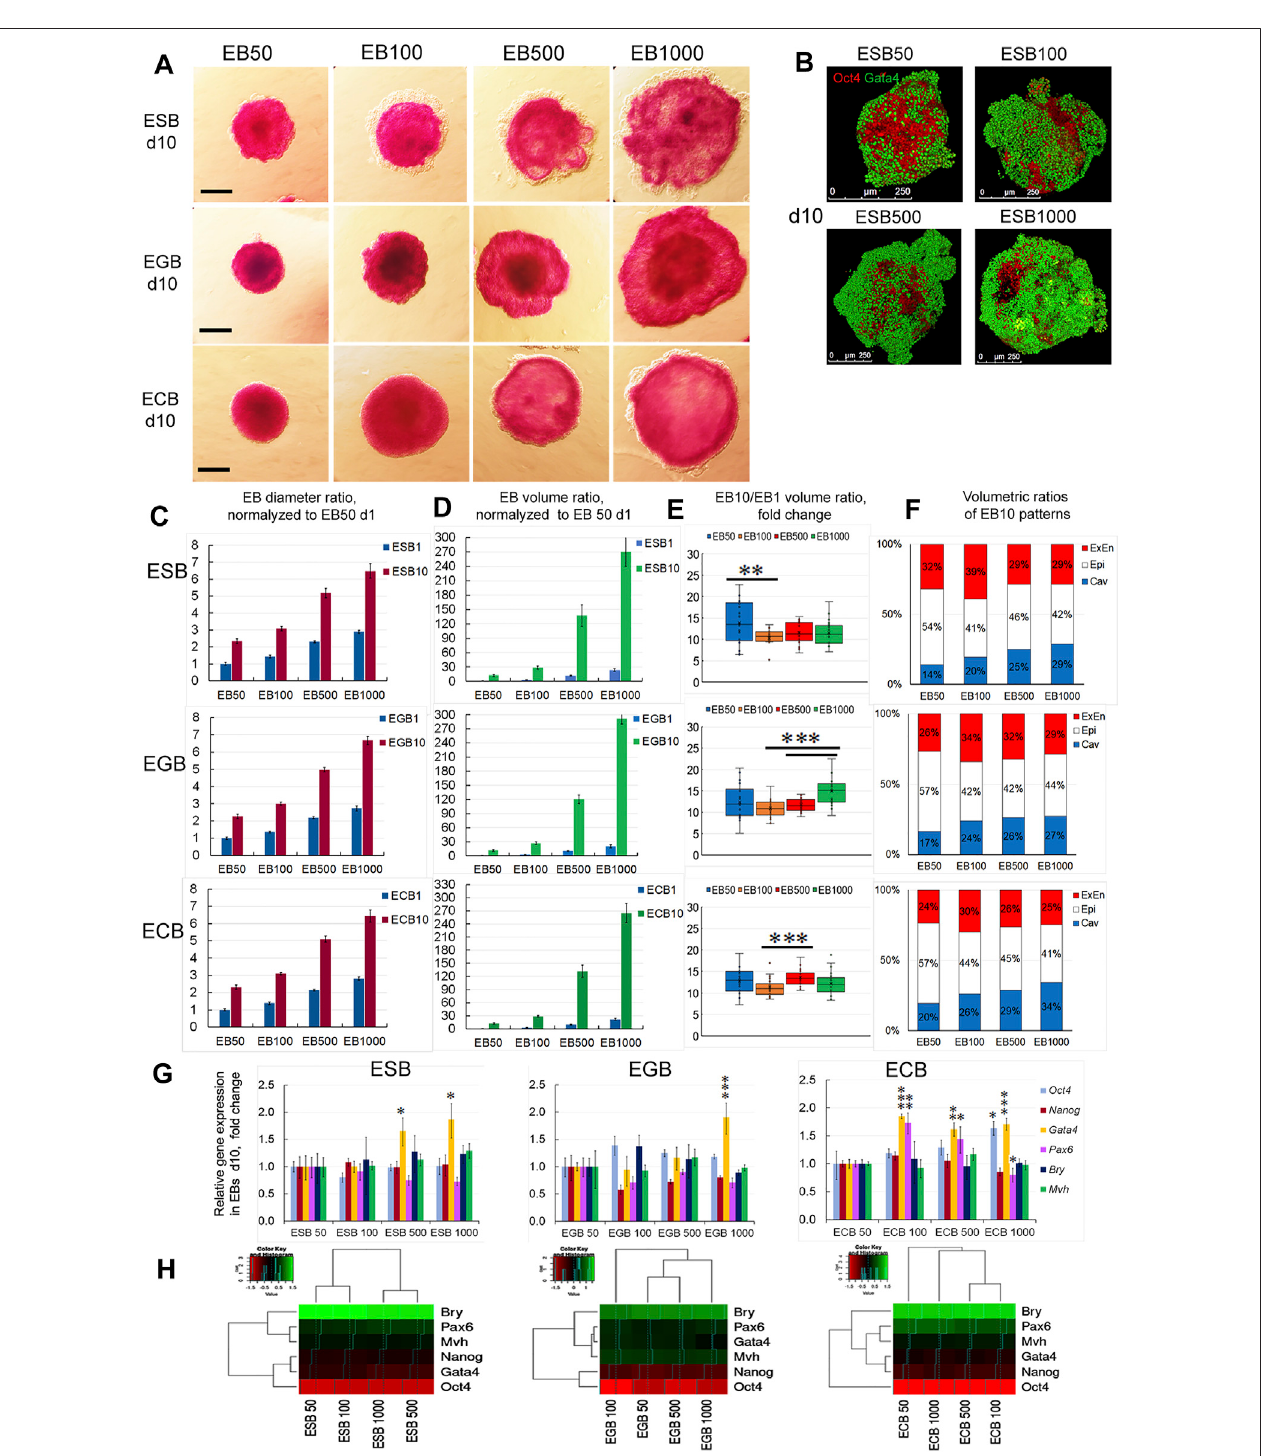
FIGURE 7 | Growth, differentiation, and patterning of EBs formed by different cell numbers. (A) ALP-staining of ESBs, EGBs, and ECBs formed by 50,100, 500, and 1,000 cells at the 10th day ofdifferentiation. (B) 3D reconstructedmodels ofspatial patterns of the Oct4 and Gata4 expressing cells in ESBs formed by different cell numbersatday10. (C,D) DiameterandvolumeratiosfordifferentlysizedESBs,EGBs,andECBsnormalizedtorespectiveEB50atday1(24EBs/pergroupforeachcell line;three experiments; N =288 for each cell line), data presented as averaged means ± s.d. (E) Volumetricratios ofEB10 toEB1for differently sized ESBs, EGBs, and ECBs day1 (24 EBs/per group for each cell line; three experiments; N = 576 for each cell line). Data presented as boxplots with means and the 25th and 75th percentile range; whiskers indicate maximum and minimum values. ** p < 0.01 , *** p < 0.001 , two-tailed Student ’ s unpaired t -test. (F) The stacked barplots indicate the